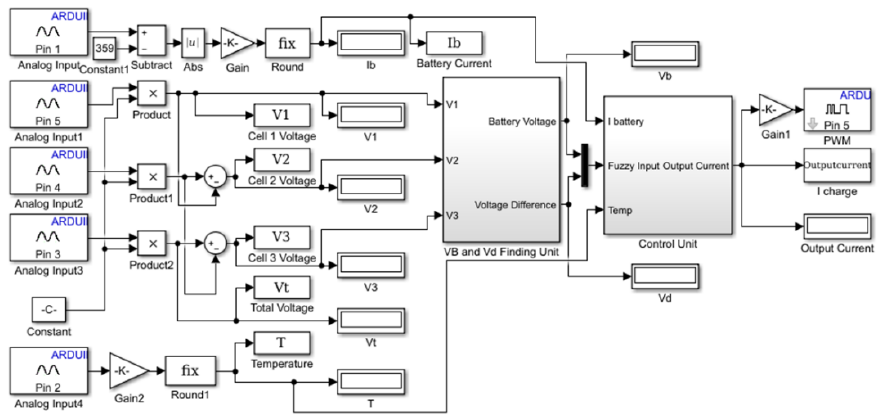
Figure 7. Real-time Simulink configuration.